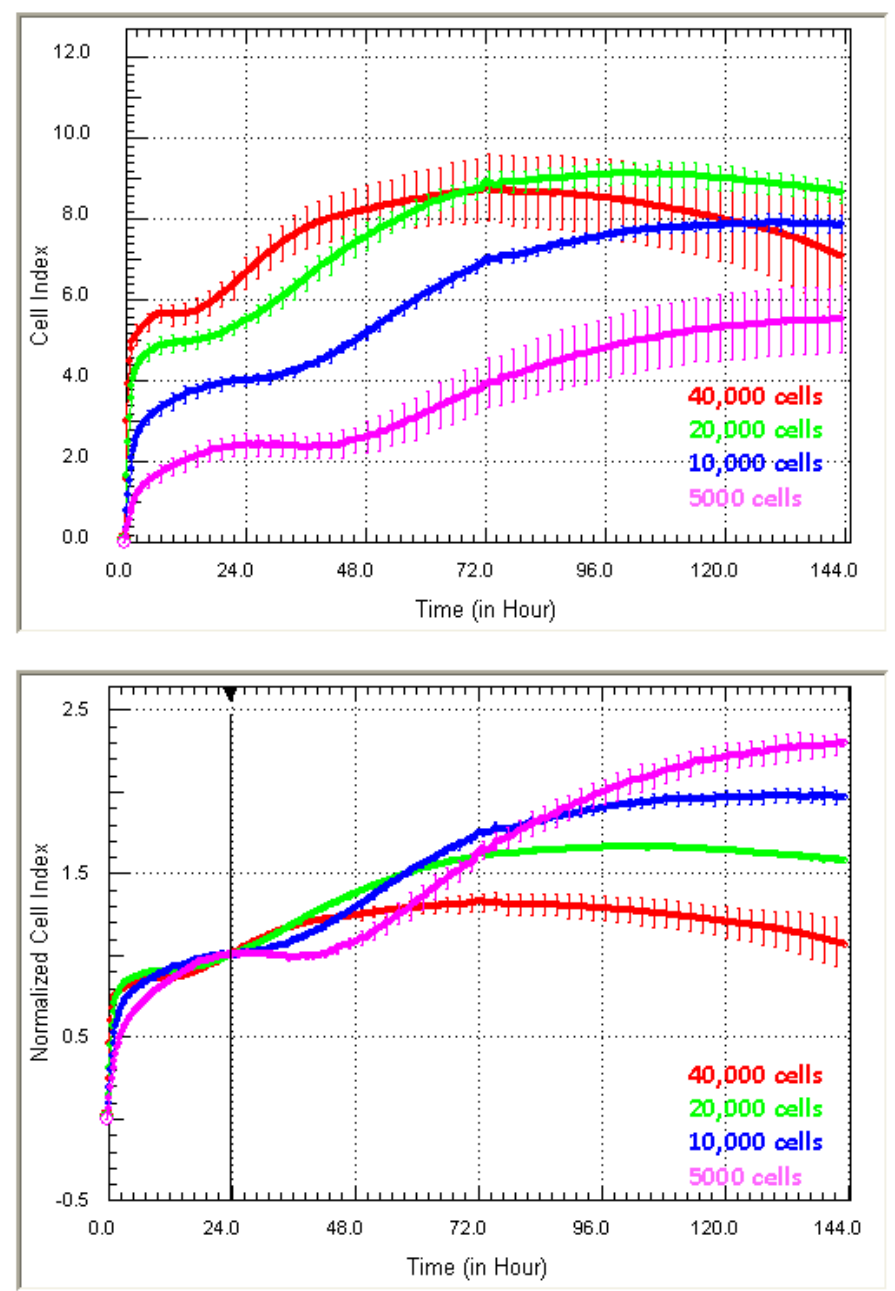
Figure A3. Cell Index vs. Normalised Cell Index. ( a , b ) show exactly the same dataset, where different densities of endothelial cell were grown for 144 h. The top panel shows the raw Cell Index data, whereas the bottom panel is normalised at 24 h (used here as a hypothetical drug treatment time point). Note the very different shapes of the Cell Index curves following normalisation. As the normalisation function converts all values to a proportion of 1.0, important information is lost in the